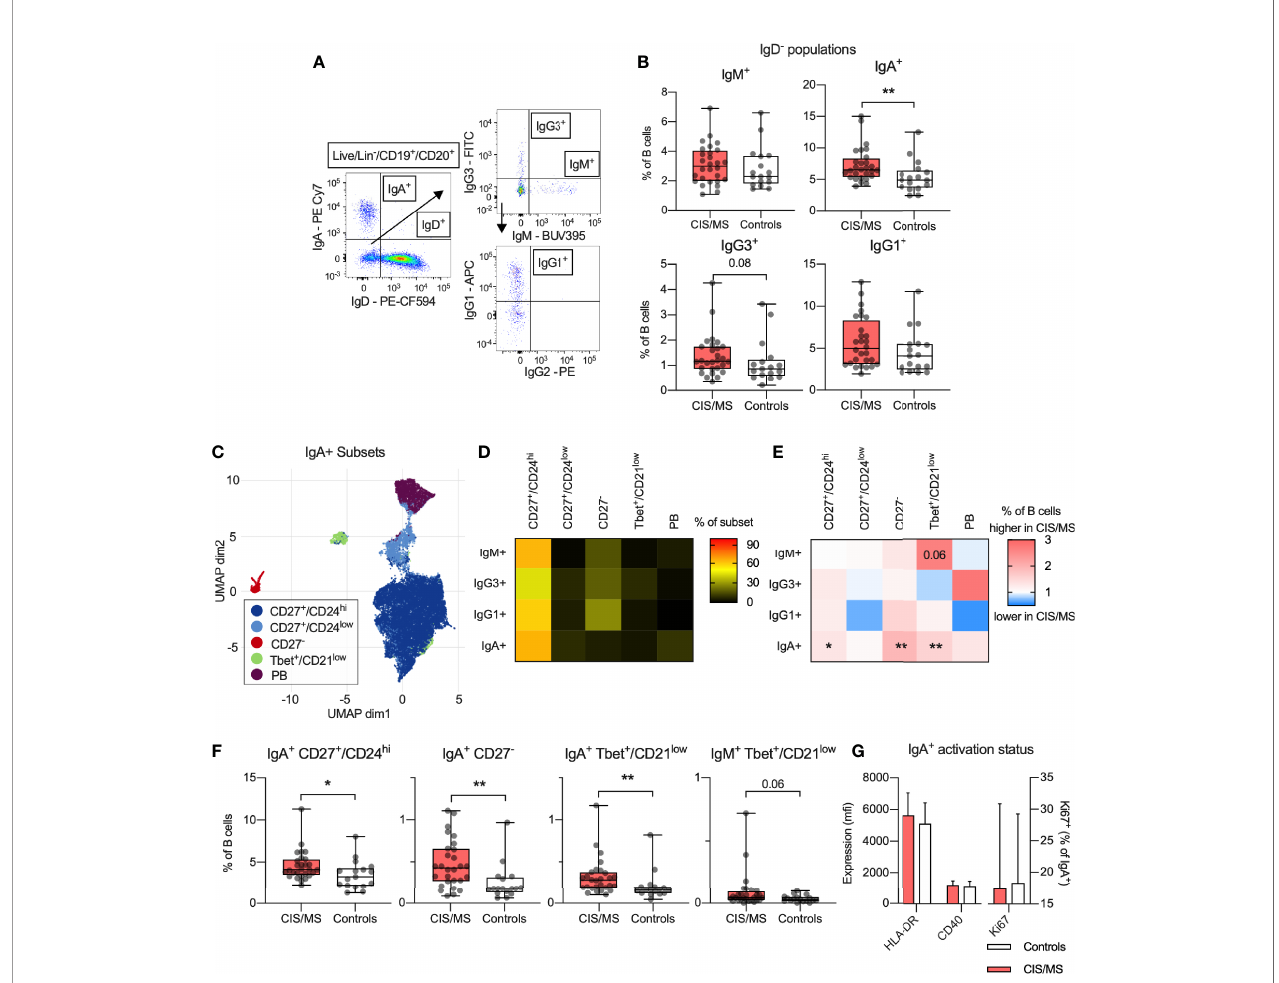
FIGURE 2 | (A) Gating strategy of isotype speci fi c B cell subsets. (B) Abundance of IgM + , IgA + , IgG3 + and IgG1 + MBC within the B cell population in CIS/MS patients compared to controls. (C) Clusters identi fi ed using FlowSOM clustering and UMAP-based visualization on IgA + MBC. (D) Abundance of identi fi ed